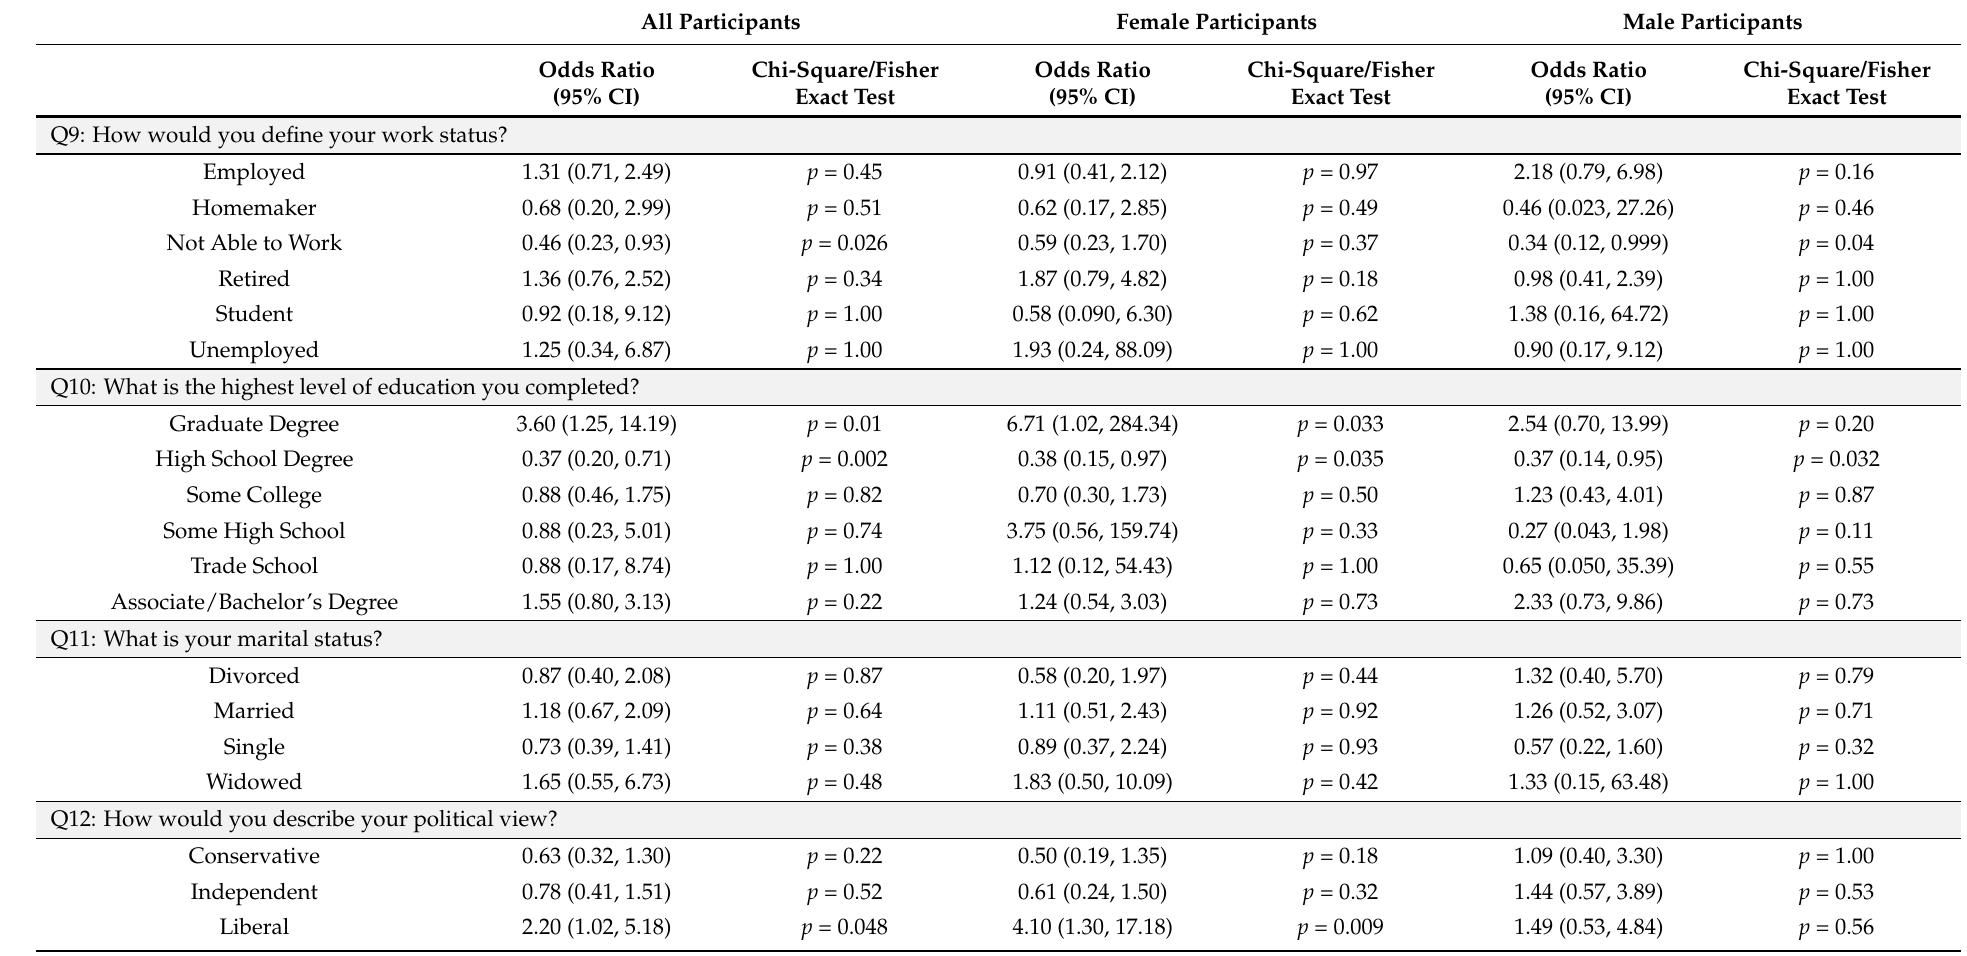
All Participants Female Participants Male